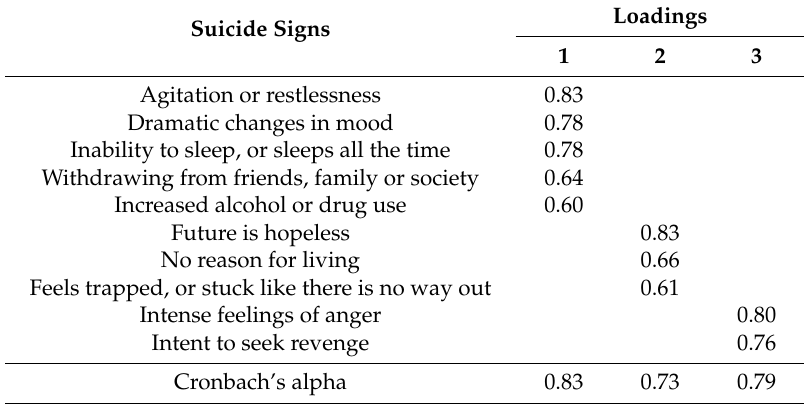
Table 3. Direct oblimin rotated factor structure of patterns of suicide signs associated with suicide risk in female crisis line